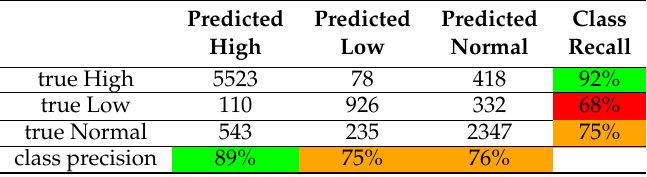
Table 3. Confusion matrix for